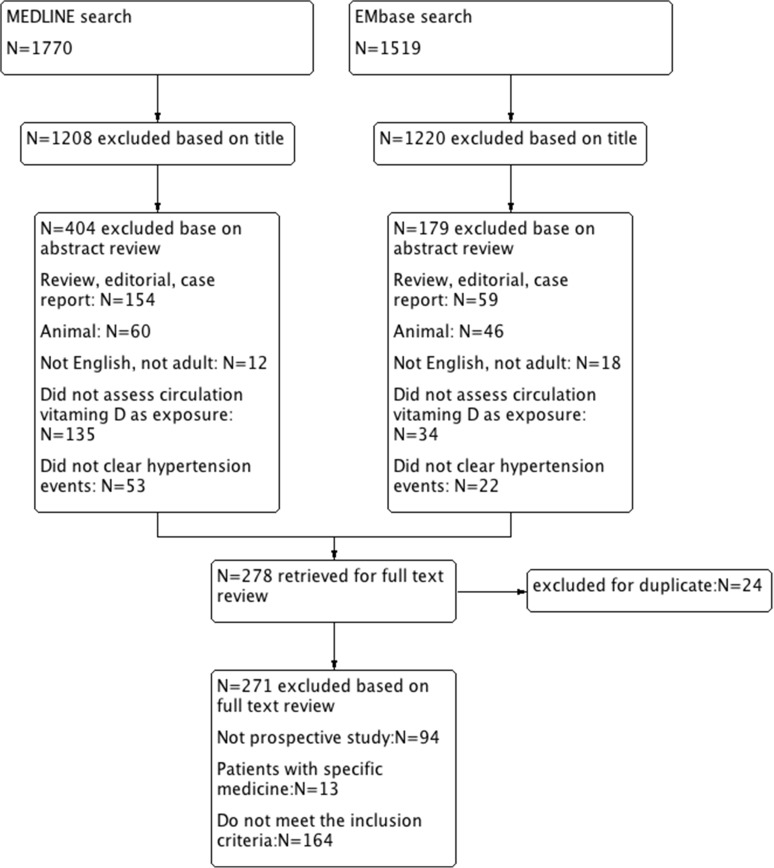
Flow diagram.Study search and flow diagram. Search terms for vitamin D included vitamin D, 25hydroxy-vitamin D, 1,25dihydroxy-vitamin D, calcidiol, and calcitriol. Search terms for hypertension included hypertension, high blood pressure, blood pressure, systolic blood pressure and diastolic blood pressure. Initial search results were further limited to English-language articles, Chinese-language articles, human studies, and studies of adults 18 years. In each box, the sum of studies in all categories may exceed the total number because of overlapping classification.